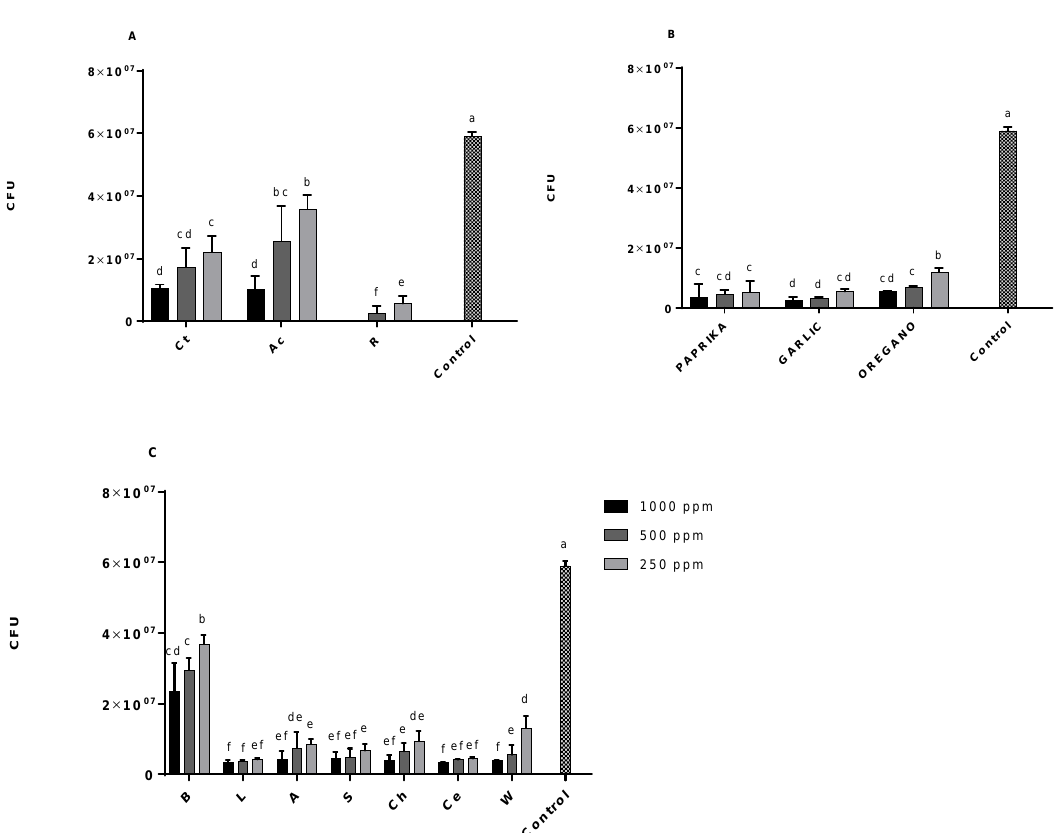
Figure 1. Antimicrobial activity of natural extracts expressed by bacterial growth (cfu) at different concentrations in Clostridium perfringens NCTC 8237 CECT 376 after 48 h incubation at 37 °C under anaerobic conditions. ( A ) obtained results for Ct: Citric; R: Rosemary; Ac: Acerola; ( B ) obtained results for Paprika, Garlic, and Oregano; ( C ) obtained results for L: Lettuce; A: Arugula; S: Spinach; Ch: Chard; Ce: Celery; W: Watercress. Superscript letters indicate significant differences ( p < 0.05) between samples. Control sample represents the normal bacterial growth without any extract.